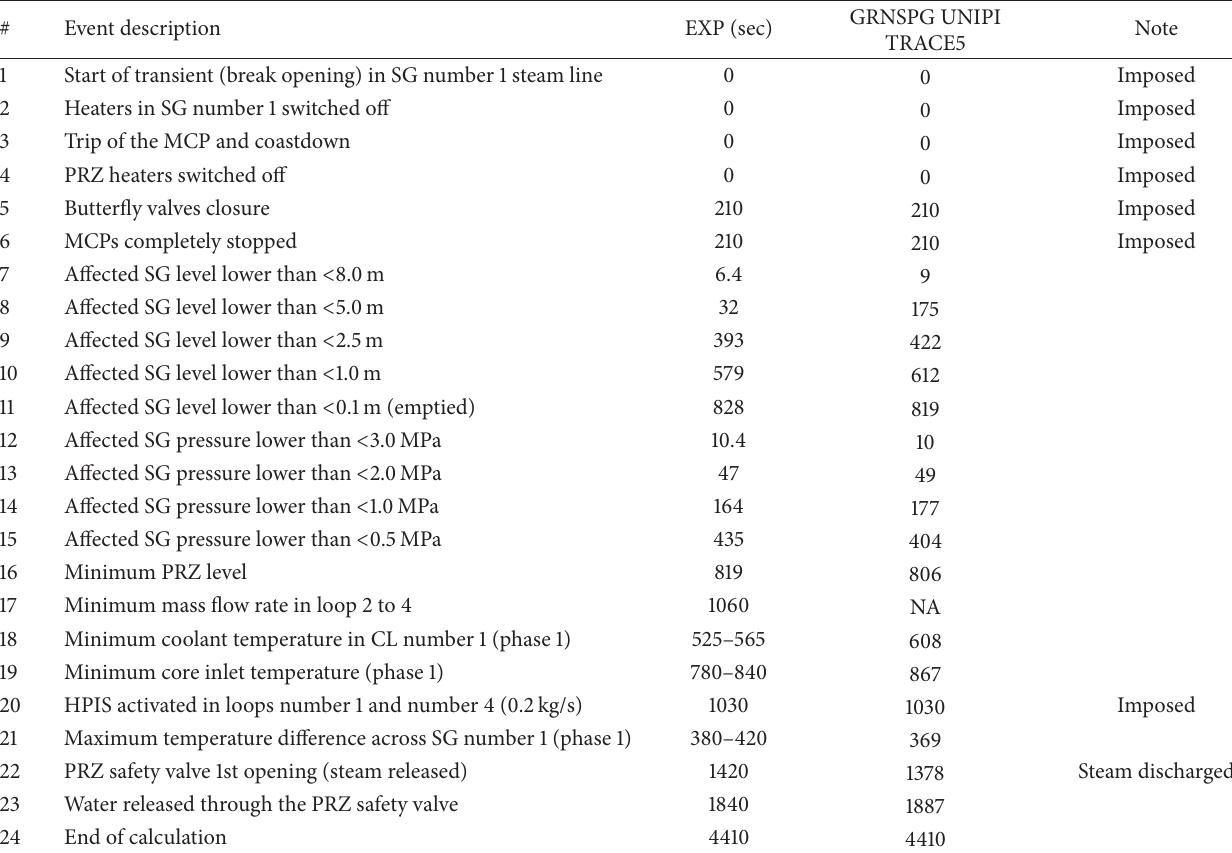
Table 2: Post test: resulting sequence of main